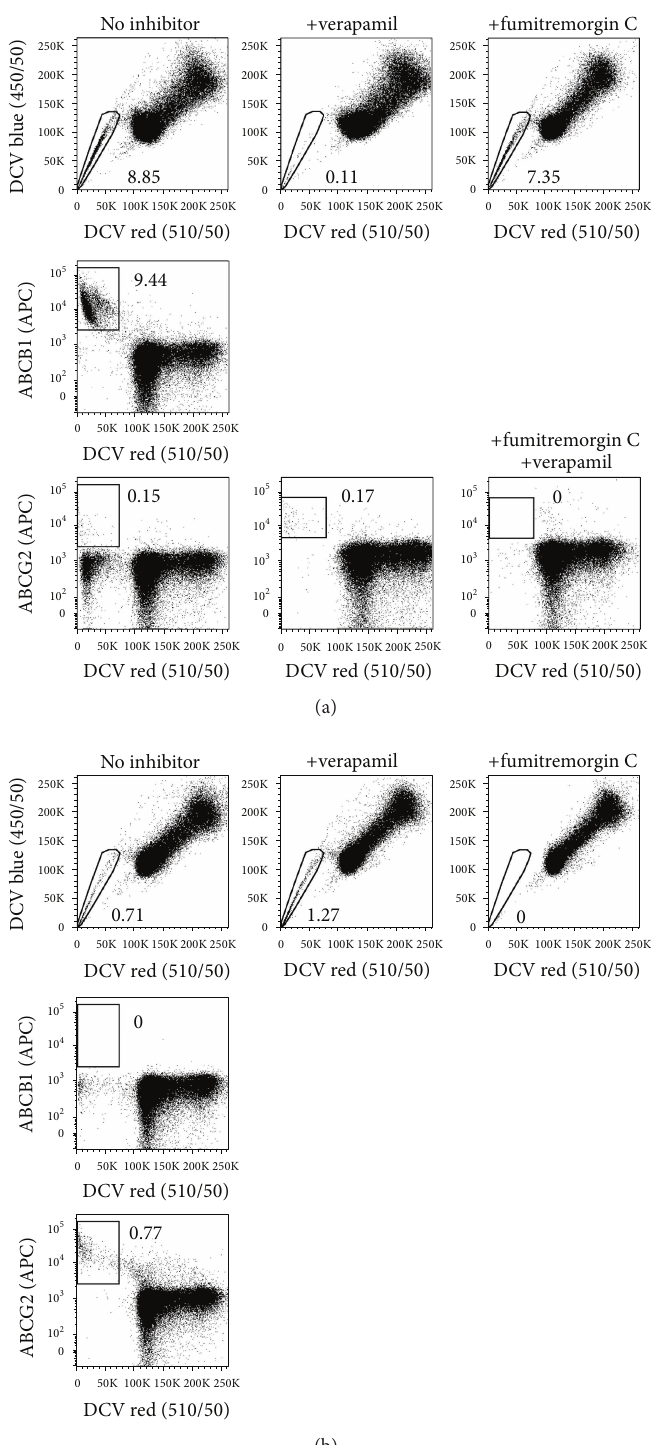
Figure 4: Characterization of DCV-SP cells using pharmacological inhibition and antibody-based costaining of SP-conferring drug transporters. A2780V cells containing ABCB1-positive SP (a) and parental A2780 cells harbouring an ABCG2-positive SP (b) were stained with 10 𝜇 M DCV (10 6 cells/mL) and subjected to a set of control experiments. Specifically, the samples were inhibited using 50 𝜇 M verapamil (blocking several drug transporters) or 20 𝜇 M fumitremorgin C (blocking ABCG2 specifically) or, where indicated, both. In addition, noninhibited and inhibited cells were costained for the drug transporters ABCB1 and ABCG2 using respective monoclonal antibodies. This multimodal approach helped us to better define particularly A2780V cells, whose SP contains a major population of ABCB1-positive cells ( ∼ 8–10%) and a minor population of ABCG2-expressing cells ( ∼ 0.1%). Note that, at least in our model systems, verapamil does not inhibit the activity of